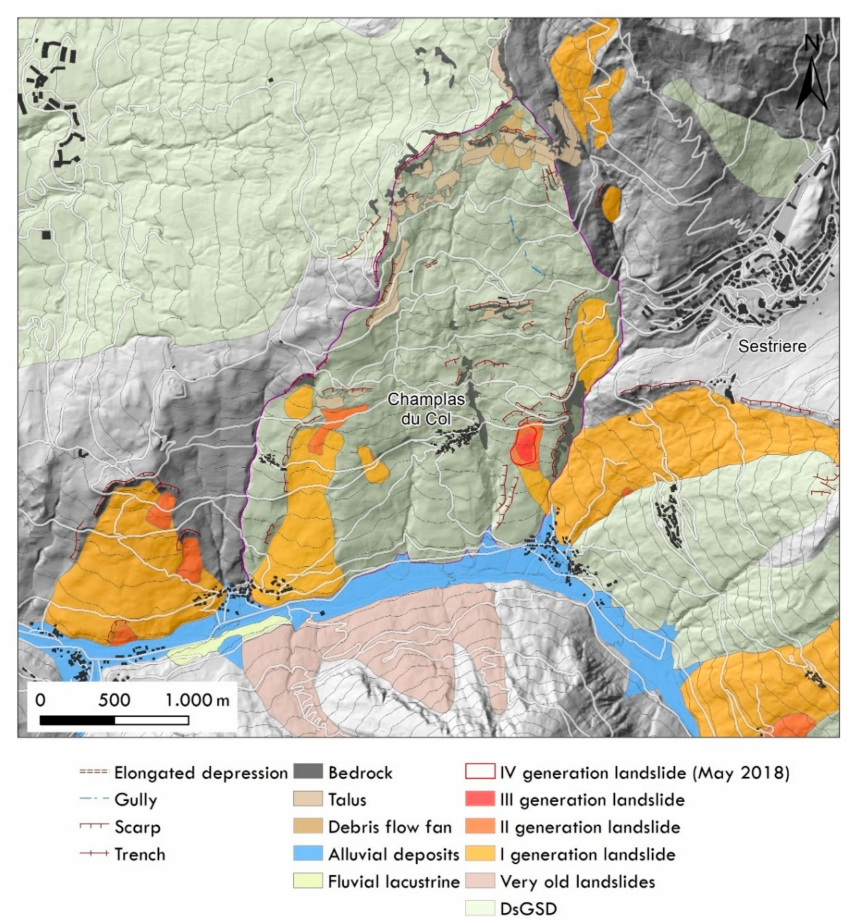
Figure 5. Landslide map of the area of interest distinguished on the basis of temporal